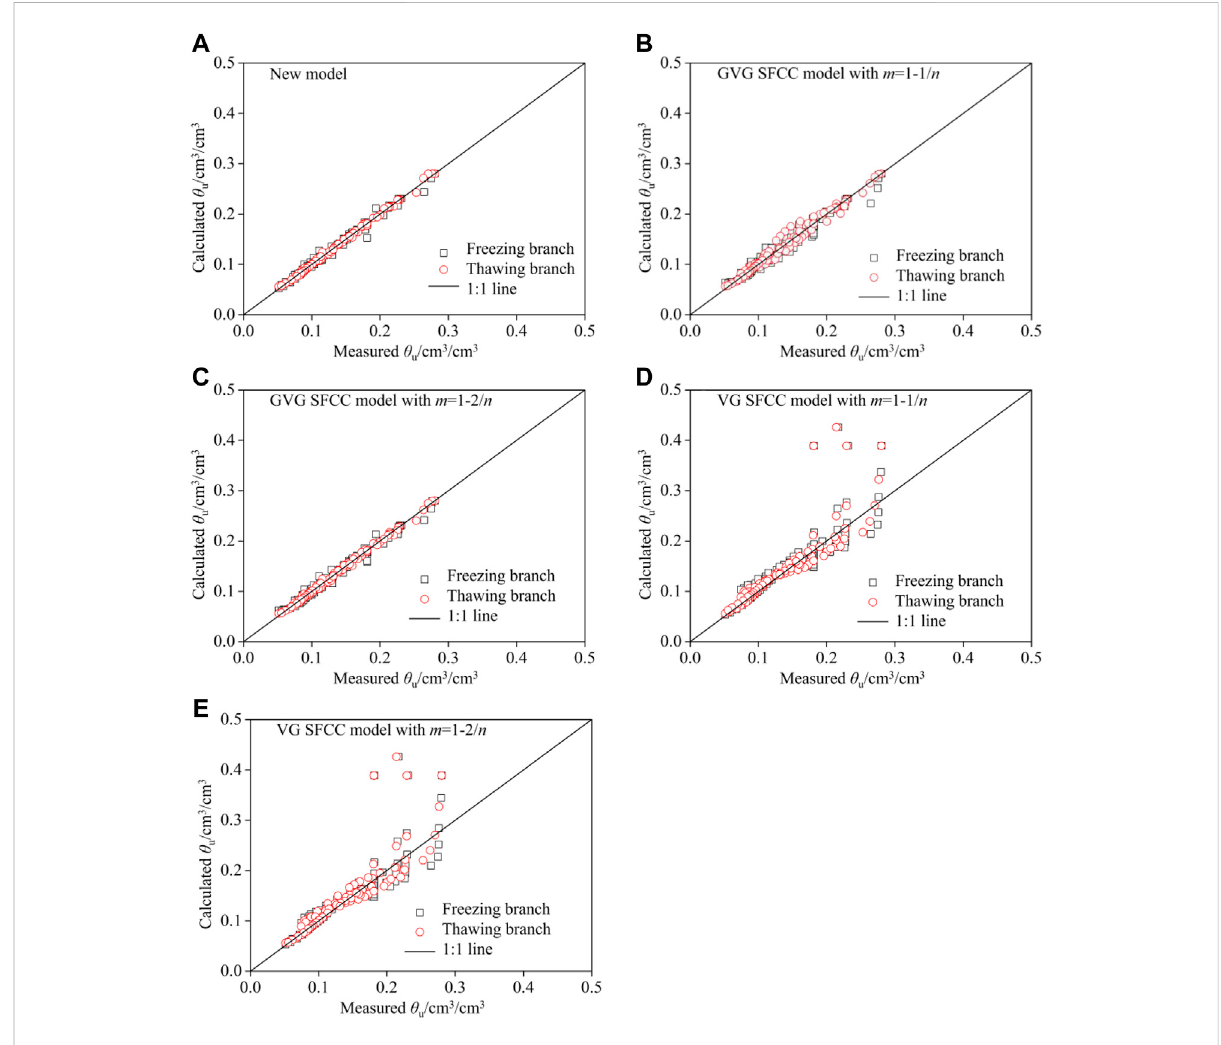
FIGURE 10 Comparison of measured and estimated